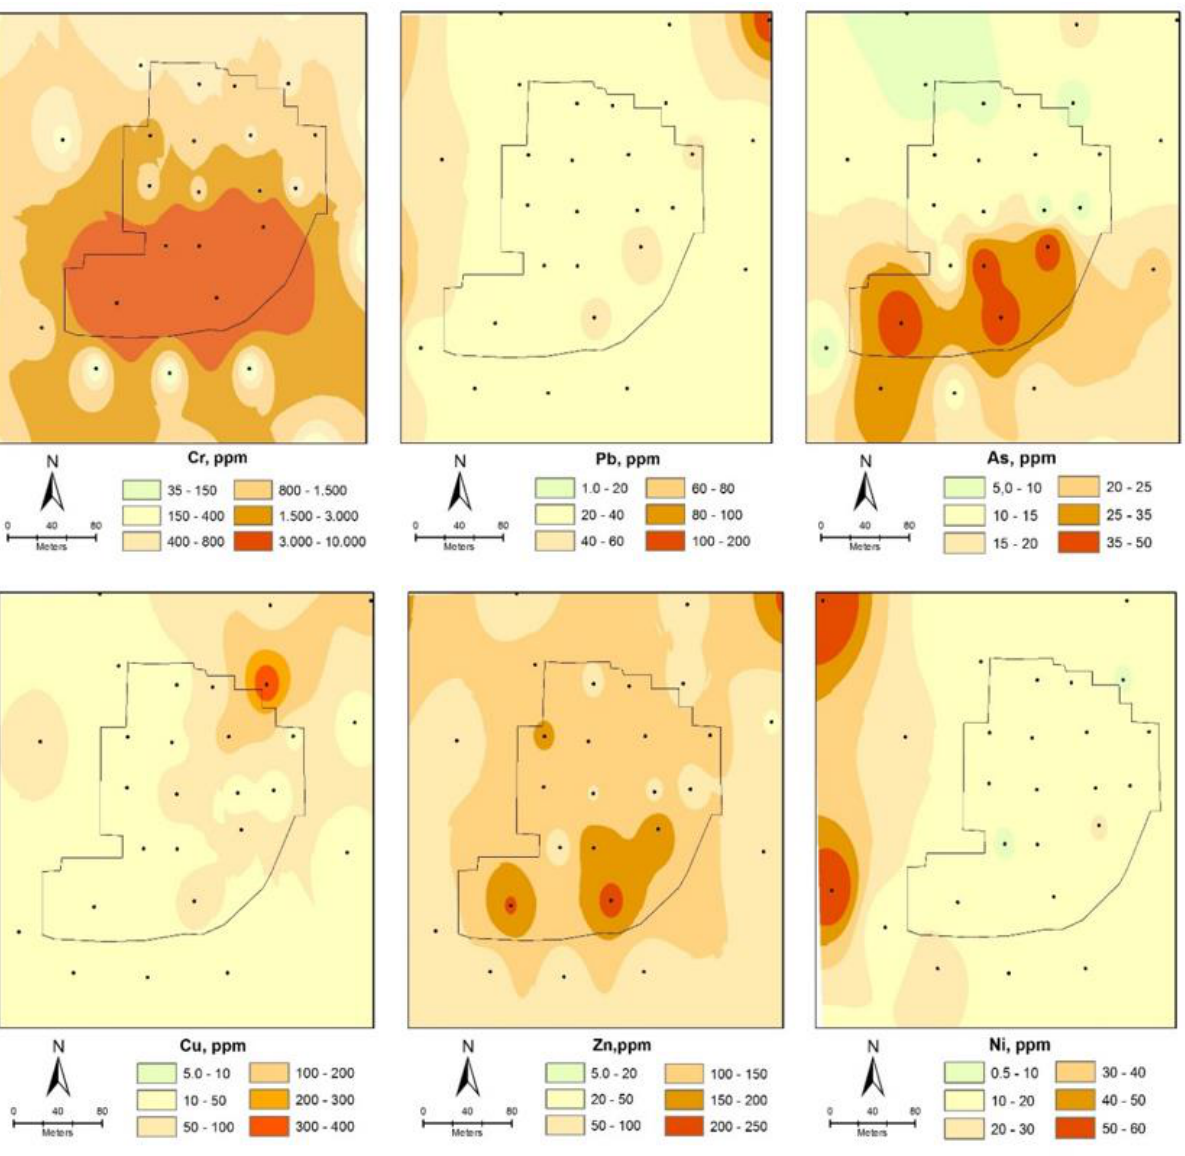
Figure 3 . Spatial distribution of heavy metals in a WWTP and a leather processing factory area. The concentrations of heavy metals are indicated by green, yellow and red in each map. The red and orange depict high concentrations, yellow and green depict low